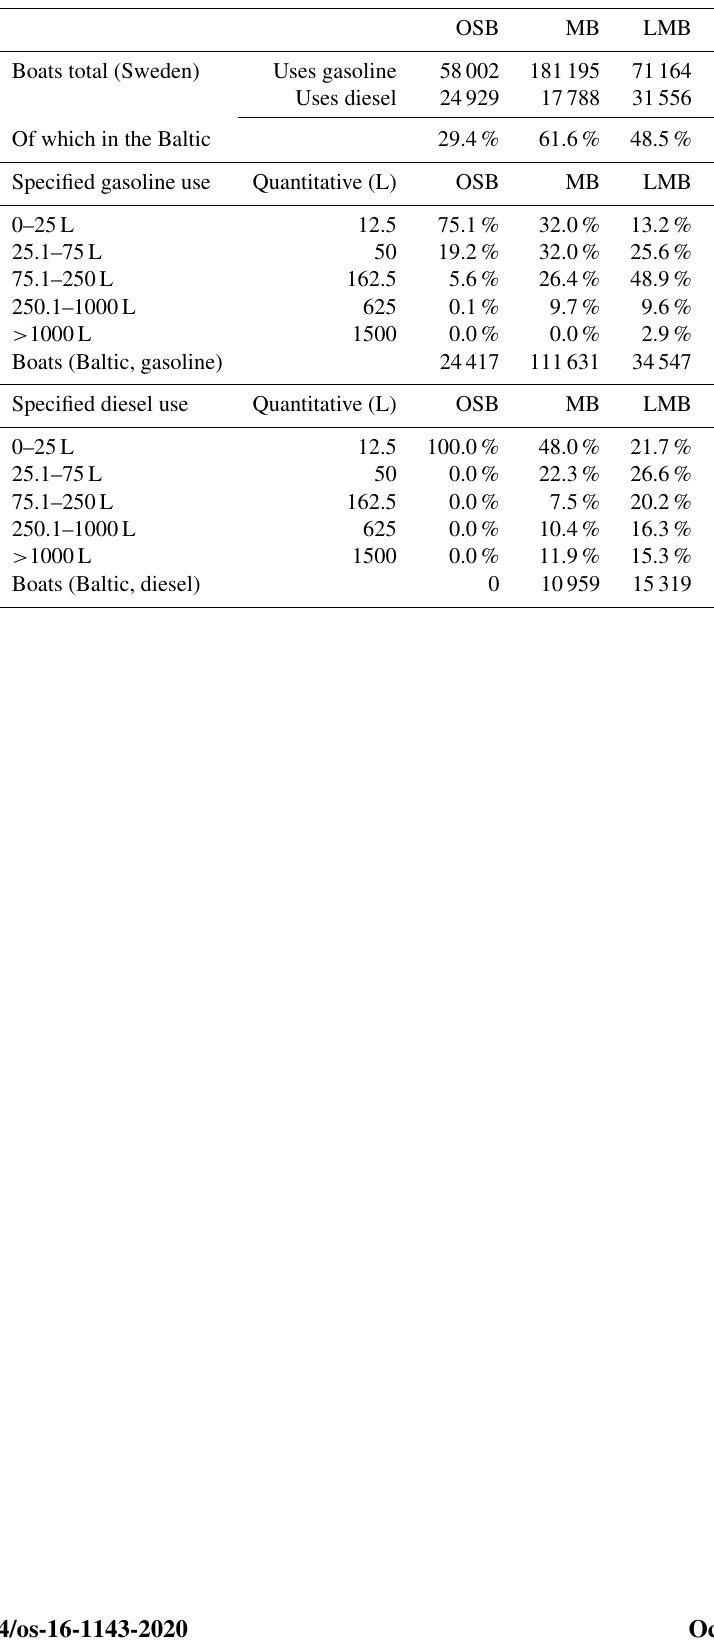
Table B1. Swedish leisure boat survey material (fuel consumption and boat counts) and derivatives processed based on the data. ”L” corre- sponds to